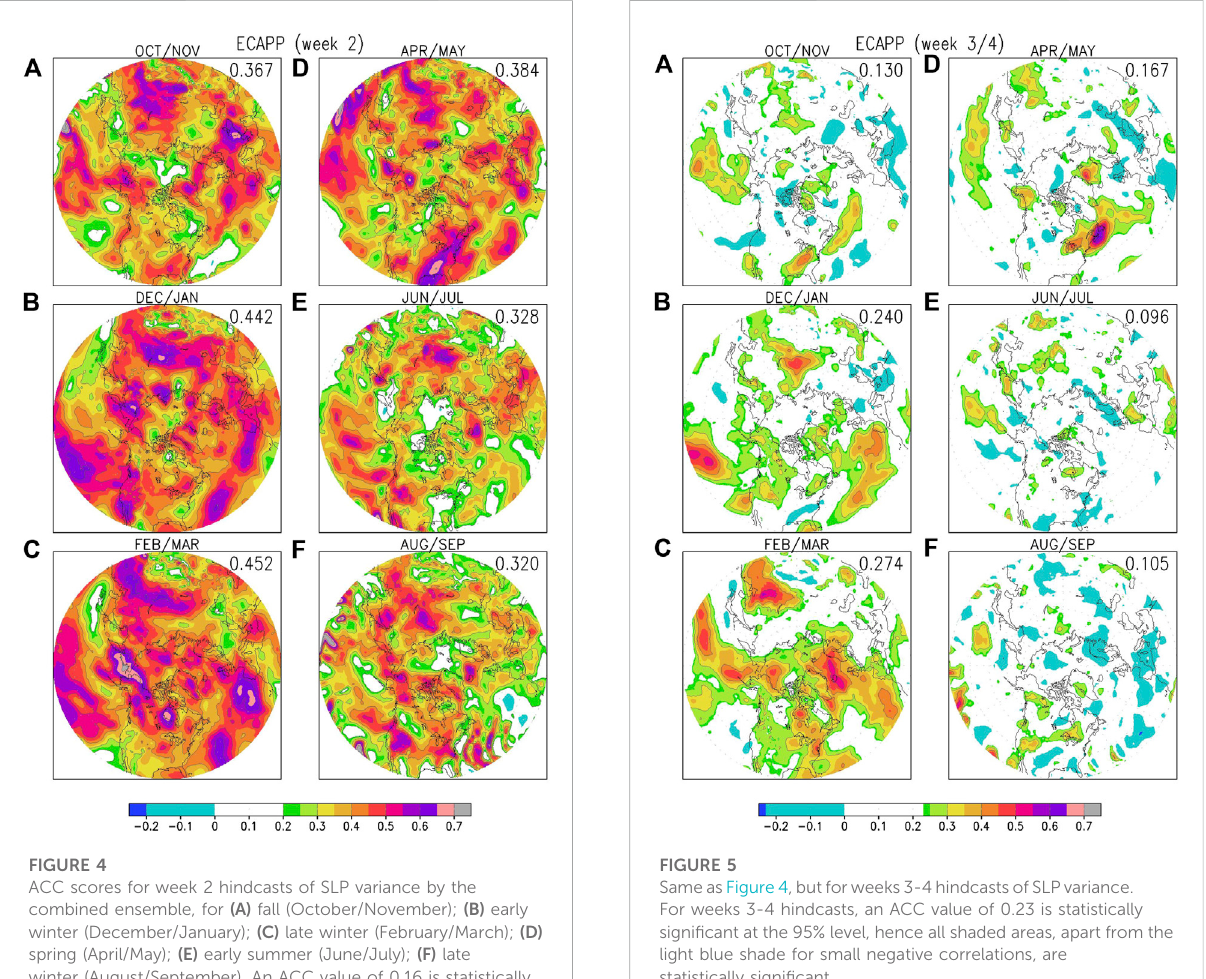
signi fi cant at the 95% level.